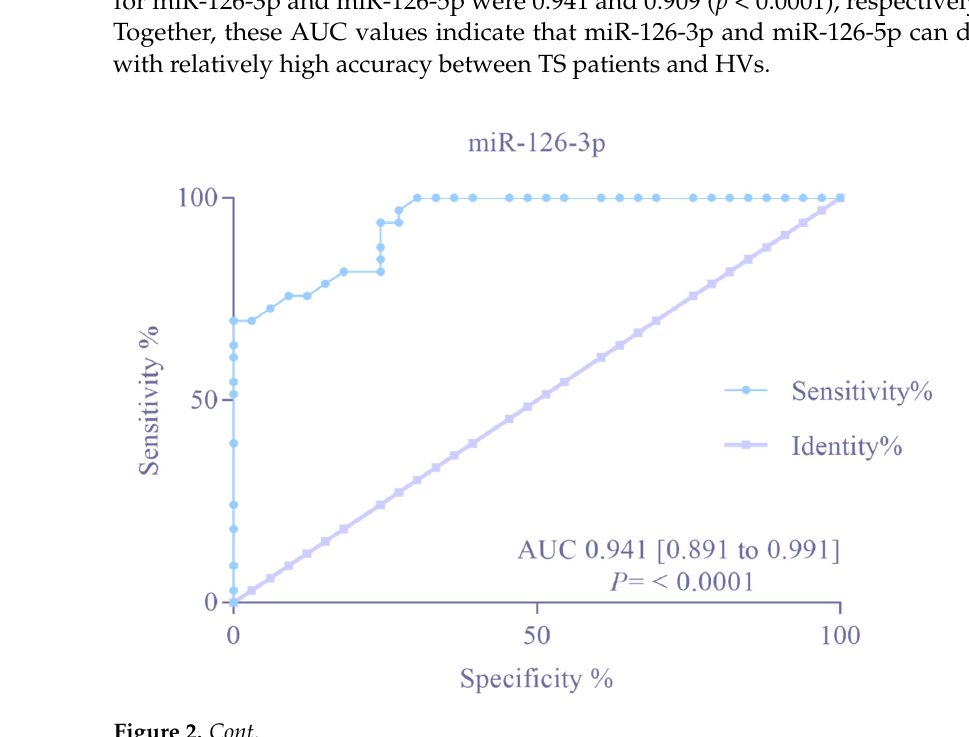
Figure 2. Receiver operating characteristic curves of miR-126-3p and miR-126-5p in Turner Syn- drome patients compared to healthy volunteers, as determined by single RT-qPCR. 4. Discussion This study demonstrated a significantly higher abundance level of miR-126-3p and miR-126-5p in TS patients compared to HVs. Within the TS cohort, the abundance levels of miR-126-3p and miR-126-5p correlated significantly with markers of aortic stiffness (AAO-S and arterial distensibility). In addition, a significant negative correlation between